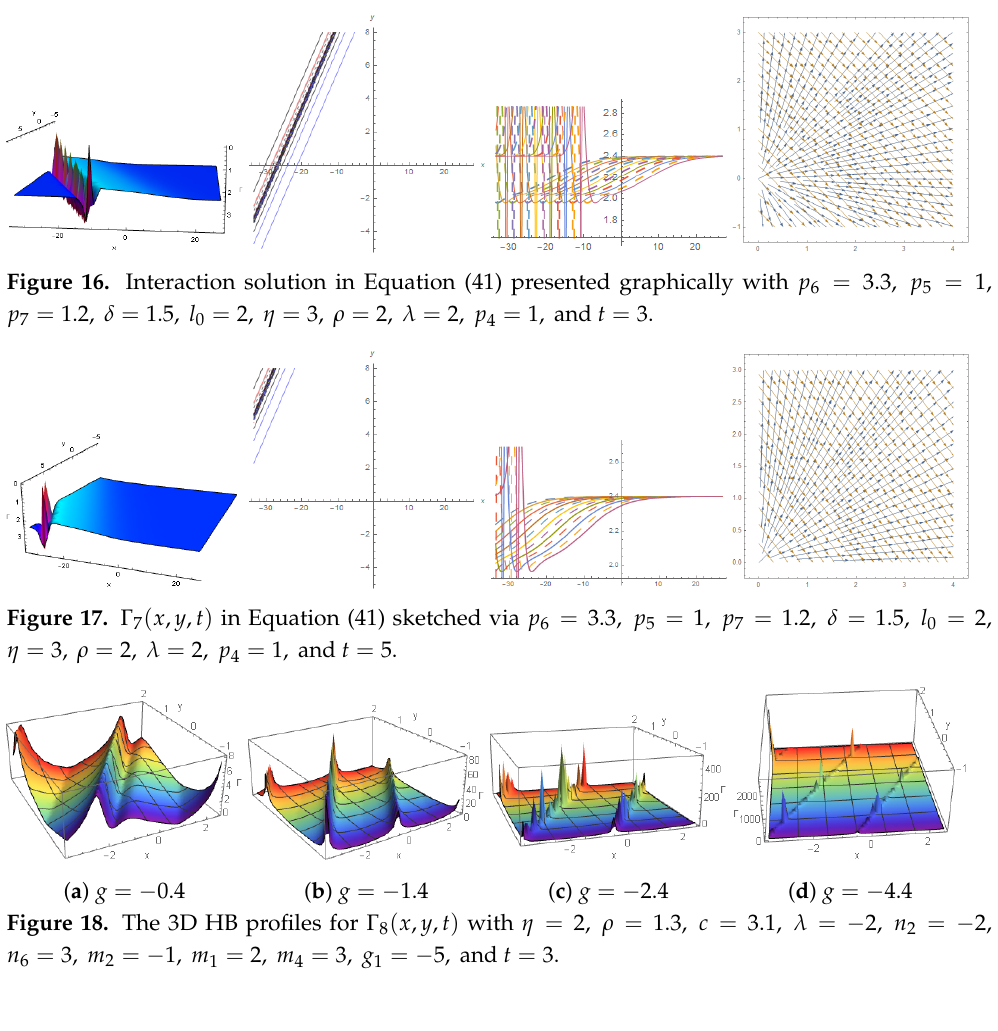
Figure 15. Γ 7 ( x , y , t ) in Equation (41) is plotted with p 6 = 3.3, p 5 = 1, p 7 = 1.2, δ = 1.5, l 0 = 2, η = 3, ρ = 2, λ = 2, p 4 = 1, and t = − 1.